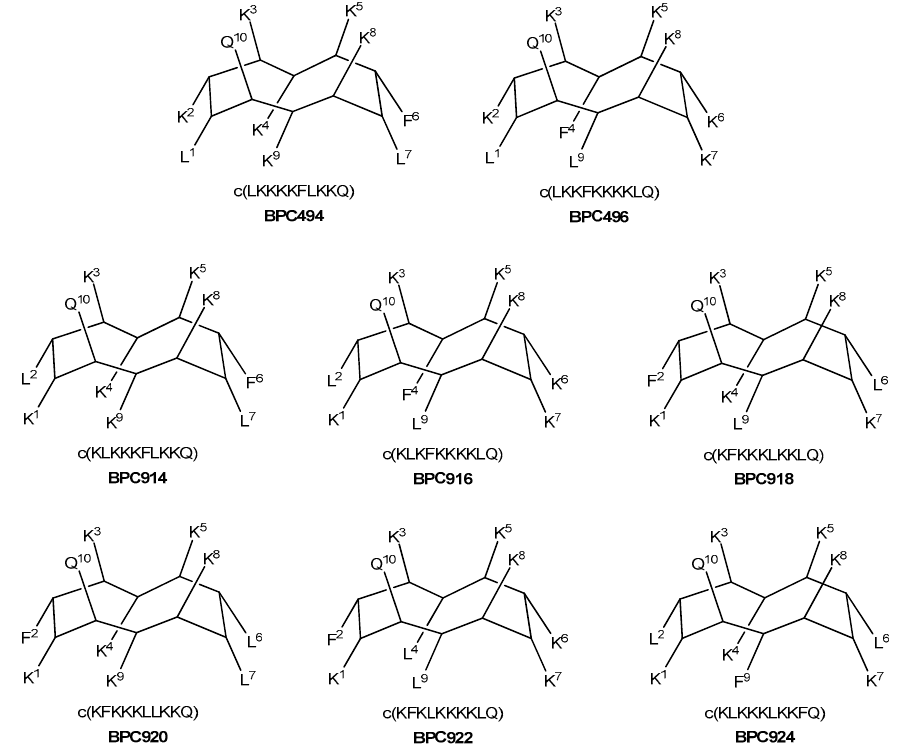
Figure 7. Sequence and hypothetic structure of the BPC198 analogues.